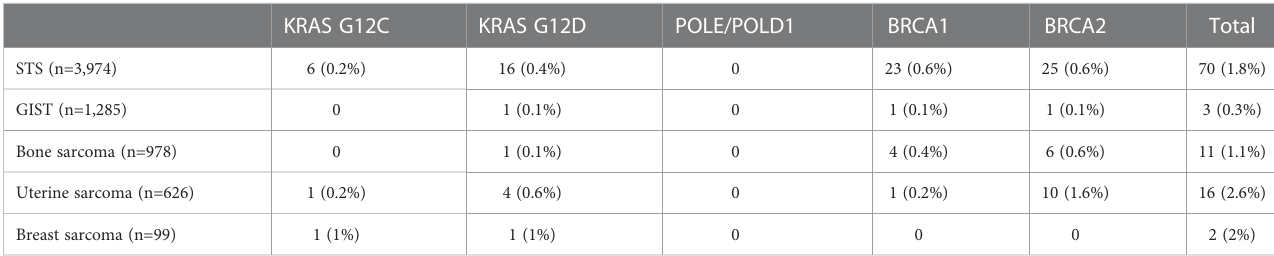
TABLE 3 Prevalence of gene mutations being investigated as potential histology-agnostic predictive biomarkers in sarcoma samples in the AACR GENIE